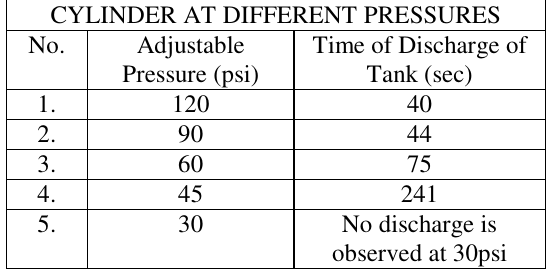
TABLE 3. TIME OF DISCHARGE